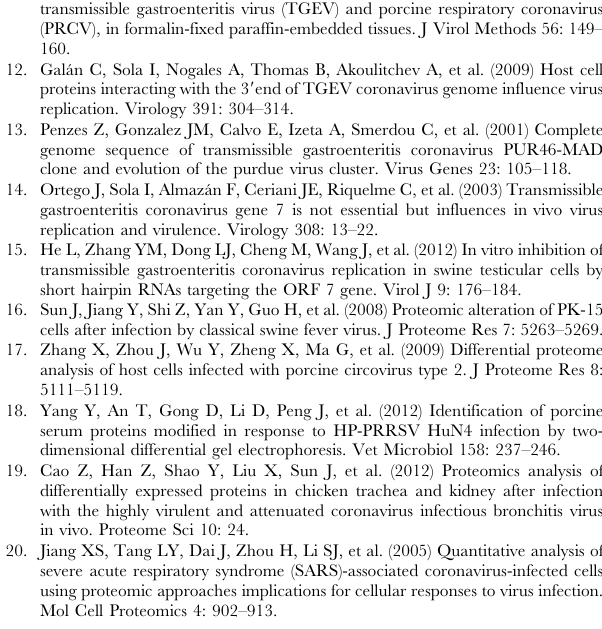
Table S2 List of the 4,112 reliably quantified proteins selected from Table S1. Table S3 Differentially expressed proteins identified under different conditions. Table S4 GO enrichment analysis of differentially expressed proteins identified at 48 hpi. Table S5 GO enrichment analysis of differentially expressed proteins identified at 64 hpi. Table S6 GO enrichment of all the